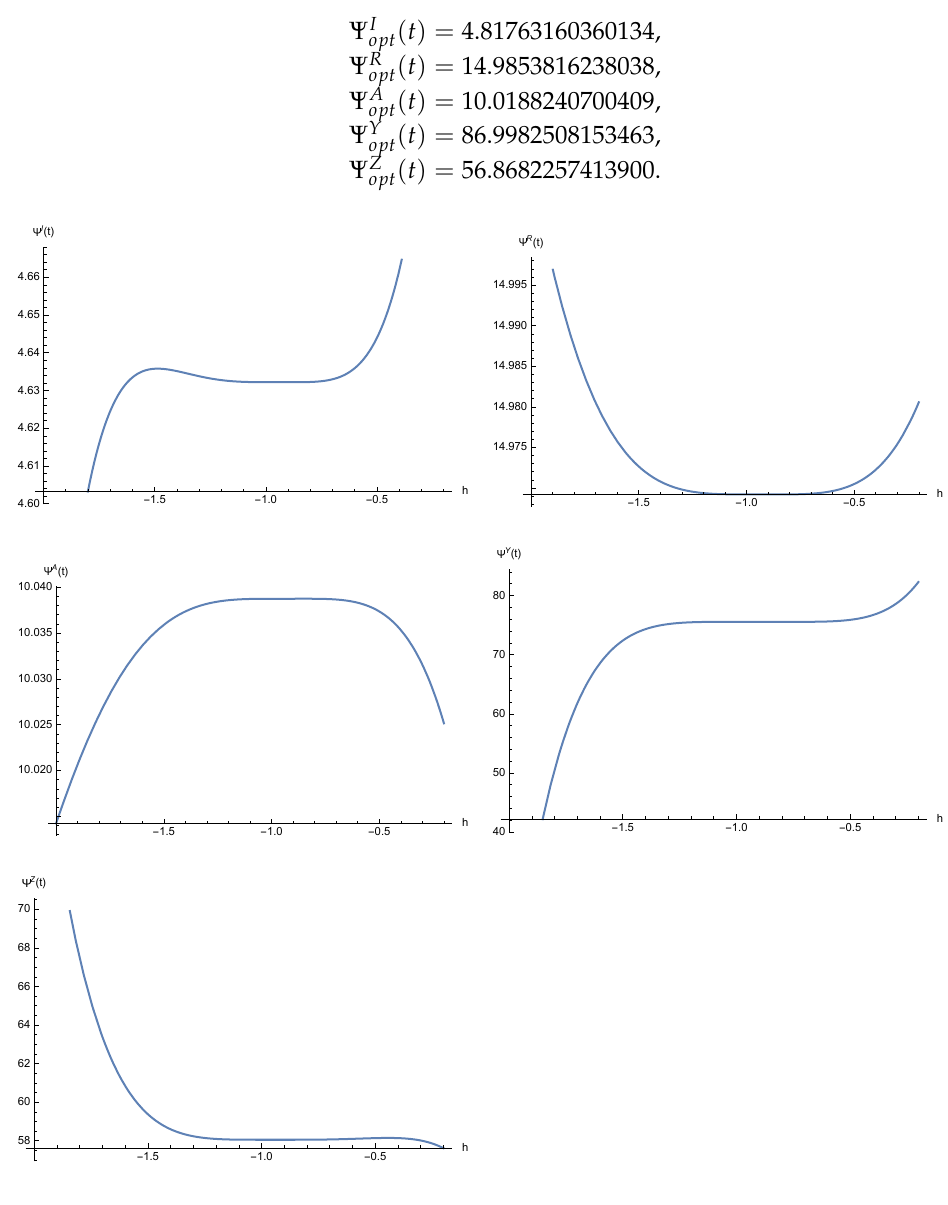
Figure 1. The ¯ h -curves for t = 1 and k =